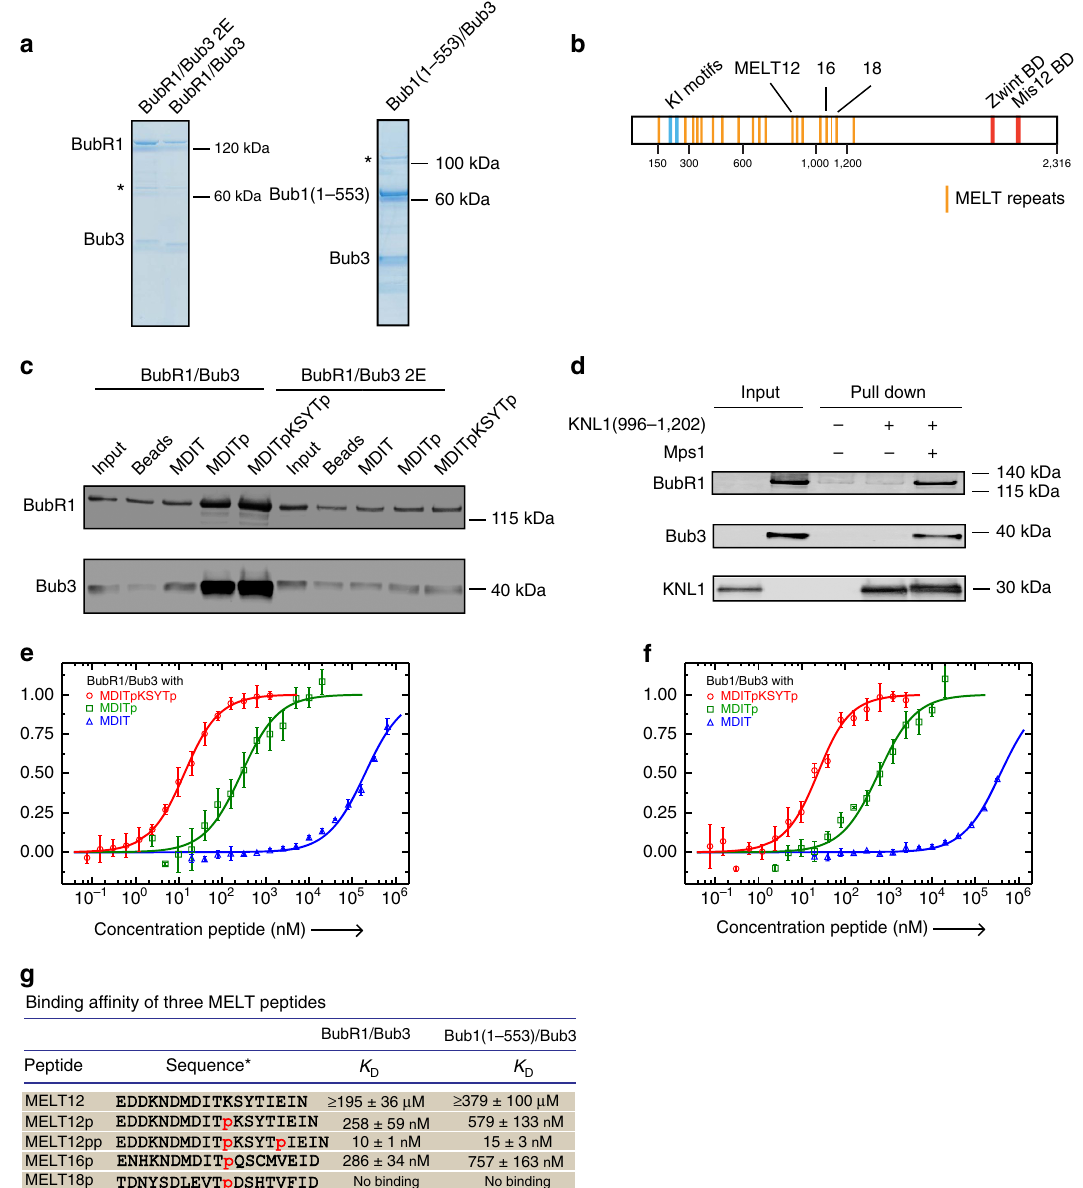
Figure 2 | BubR1/Bub3 binds directly to phosphorylated MELTrepeats. ( a ) Coomassie staining showing purified BubR1/Bub3 and BubR1/Bub3 2E (left), and purified Bub1(1–553)/Bub3 (right) from HEK293 cells. * indicates co-purifying contaminant. ( b ) Schematic of KNL1 and the position of MELT 12, 16 and 18. ( c ) Peptide-binding assay with purified BubR1/Bub3 and biotinylated MELT12 peptides was analysed by quantitative western blot with antibodies against BubR1 or Bub3. ( d ) KNL1 996–1,202 binding assay with purified BubR1/Bub3 analysed by quantitative western blot with antibodies against BubR1, Bub3 and KNL1. ( e , f ) Affinity measurement of BubR1/Bub3 ( e ) or Bub1(1–553)/Bub3 ( f ) to peptides (MELT12) with either unphosphorylated MDIT or single- phosphorylated MDITp or double-phosphorylated MDITpSYTp using MicroScale Thermophoresis (MST). Fraction bound versus the concentration of three MELT12 peptides are shown here. Data were derived from the ratio of the normalized time averaged (1s) fluorescence intensities at defined time points of the MST traces (8 and (cid:2) 1s, respectively). Lines represent fits of the data points using the law of mass action. The number of independent repeats was three for all measurements; error bars show the s.d. between these independent repeats. ( g ) Table showing K D of BubR1/Bub3 and Bub1(1–553)/Bub3 for the different MELT12 peptides (data shown in e , f ) and to single-phosphorylated MELT16 and 18. The K D constants were obtained by fitting the fraction of bound protein to the quadratic solution of the binding reaction equilibrium derived from the law of mass